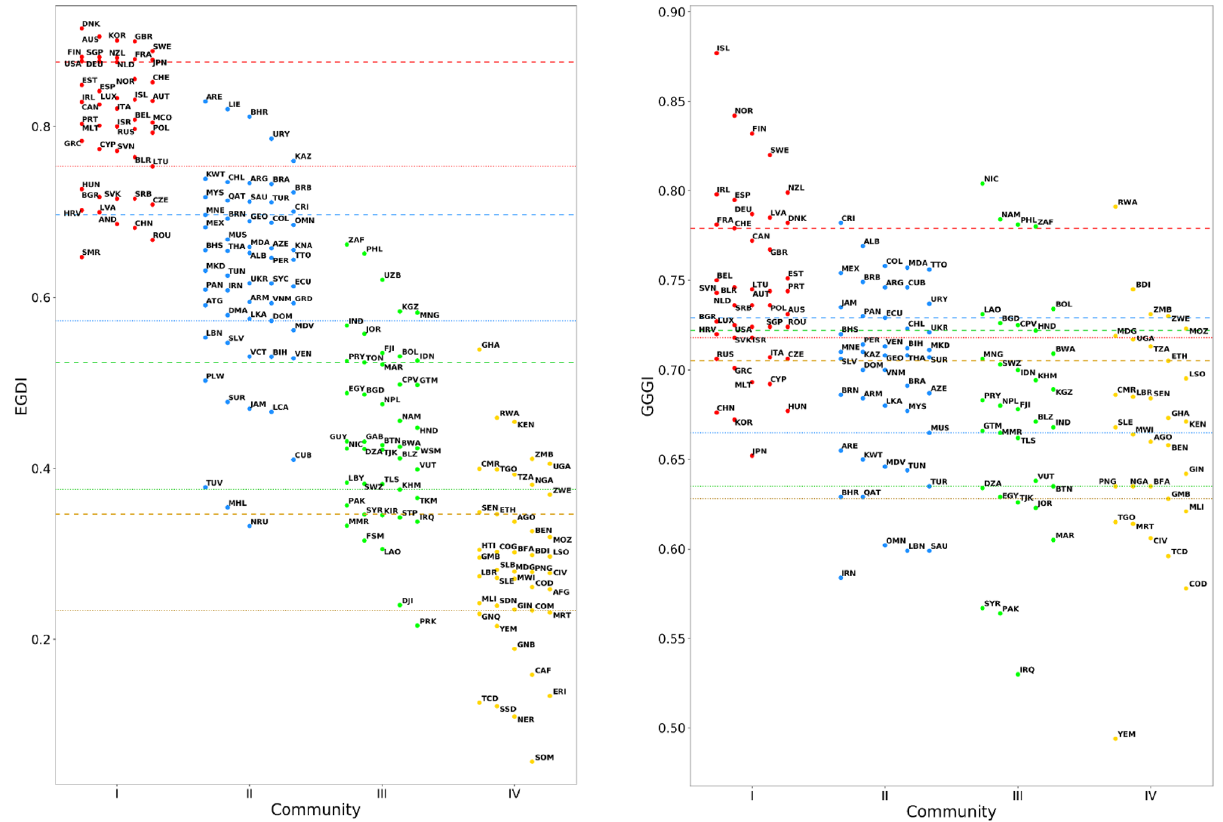
Figure 3. Distribution of EGDI (left panel) and GGGI (right panel) indexes of UN countries, separated in communities I (red), II (blue), III (green) and IV (yellow). Dashed and dotted lines of the same color as communities represent the 25th and 75th percentile, respectively, of the associated community distributions. Notice that, while the horizontal grouping of points is related to the community membership of the countries they represent, the specific abscissa of a point is not meaningful. Higher-resolution versions of the above plots are reported in Supplementary Sec.